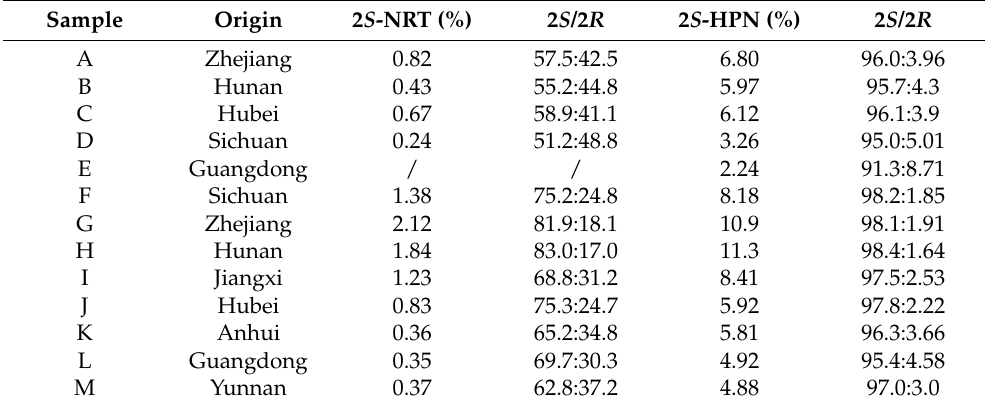
Table 4. Relative ratio of narirutin and hesperidin C-2 diastereomers in Citrus reticulata Blanco (peels of Chenpi and Qingpi).